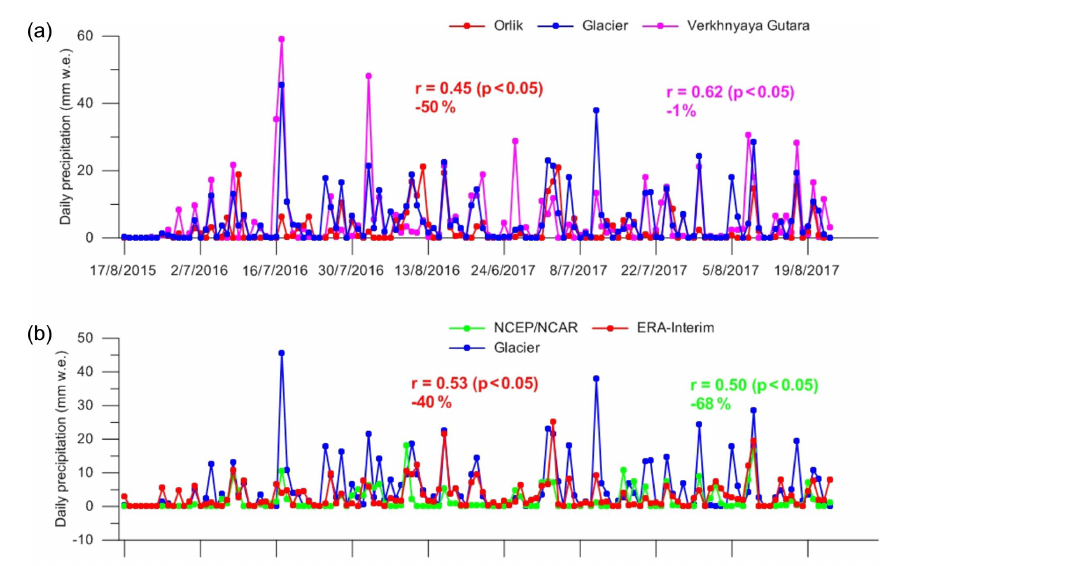
Figure 2. Precipitation records from the glacier, weather stations Orlik and Verkhnyaya Gutara (a) and NCEP/NCAR and ERA-Interim reanalysis data (b)